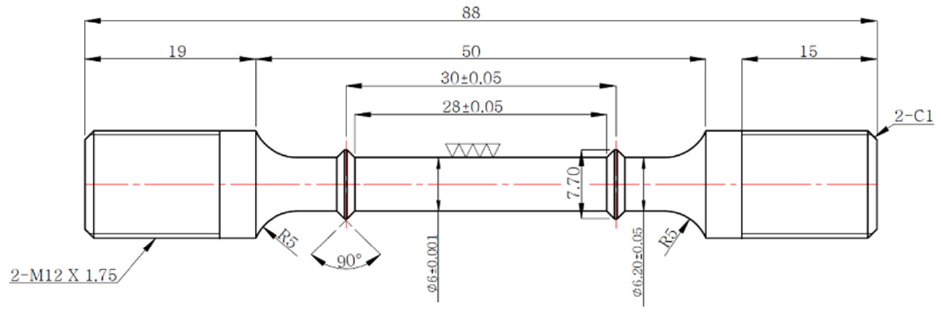
Figure 1. The dimension of specimens for the stress-rupture test (in mm).